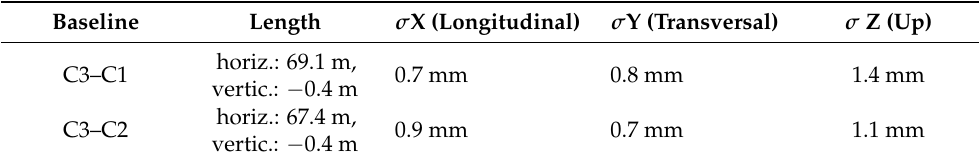
Table 3. Root mean squares (RMSs) of XYZ with respect to the mean motion (splines every 14 days) for the 2 baselines over the 1-month period.